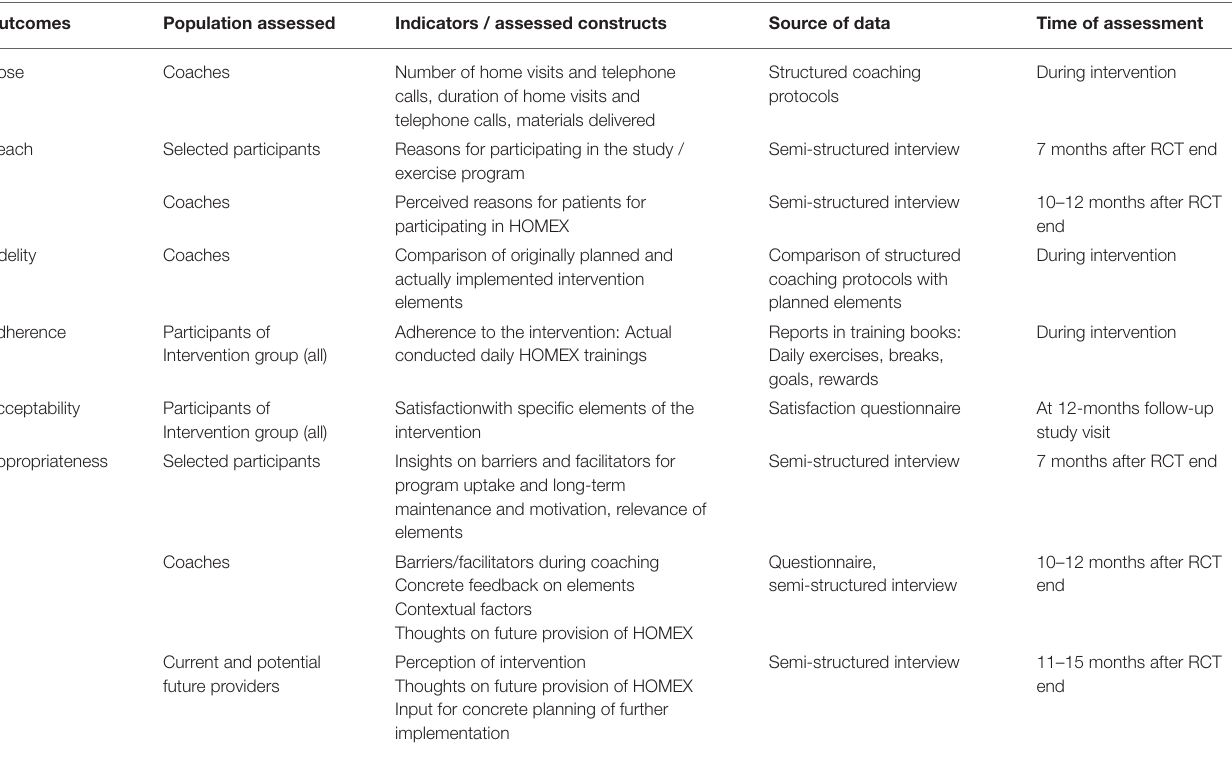
TABLE 1 | Overview on implementation outcomes and assessment